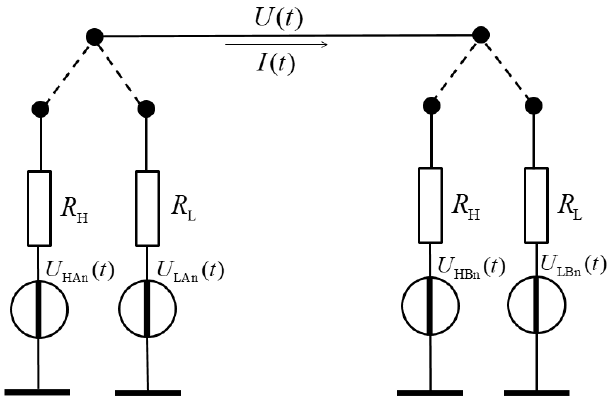
Figure 1. The core of the Kirchhoff-Law-Johnson-Noise (KLJN) system. U HAn ( t ) , U LAn ( t ) , U HBn ( t ) , and U LBn ( t ) are the (thermal) noise voltage generators for the related resistances R H and R L , respectively. U ( t ) and I ( t ) are the measured noise voltage and the current in the wire that are used to evaluate the power density spectra S u ( f ) and S i ( f ) , respectively.